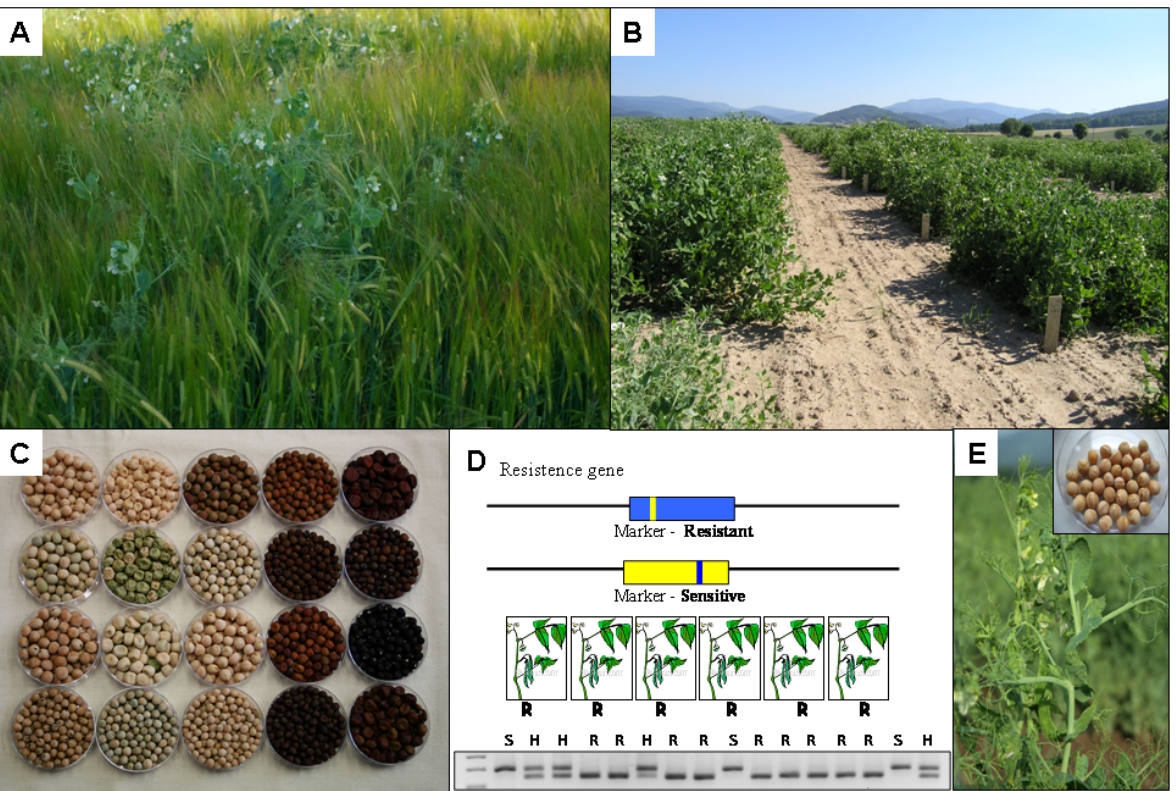
Figure 4. Examples of agronomic practices, germplasm conservation, quality attributes and disease resistance traits in pea. ( A ) Intercropping pea with cereals for nitrogen fixation and phosphorus availability. ( B ) Pea germplasm increase and maintenance at Agritec, CZ. ( C ) Display of pea seed shape and color variation. ( D ) Cartoon representing a perfect marker for PSbMV virus resistance (Smýkal et al. 2010). ( E ) PSbMV infected seed and PEMV infected pea